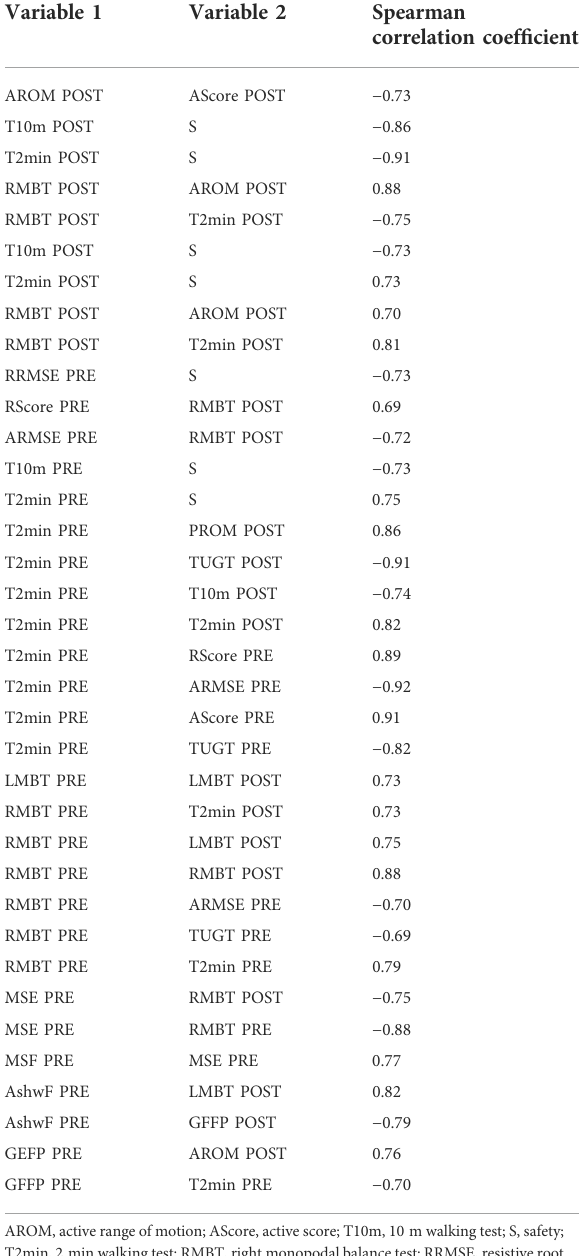
TABLE 8 Spearman correlations table ( p > 0.05) for PRE and POST – treatment variables. Variable